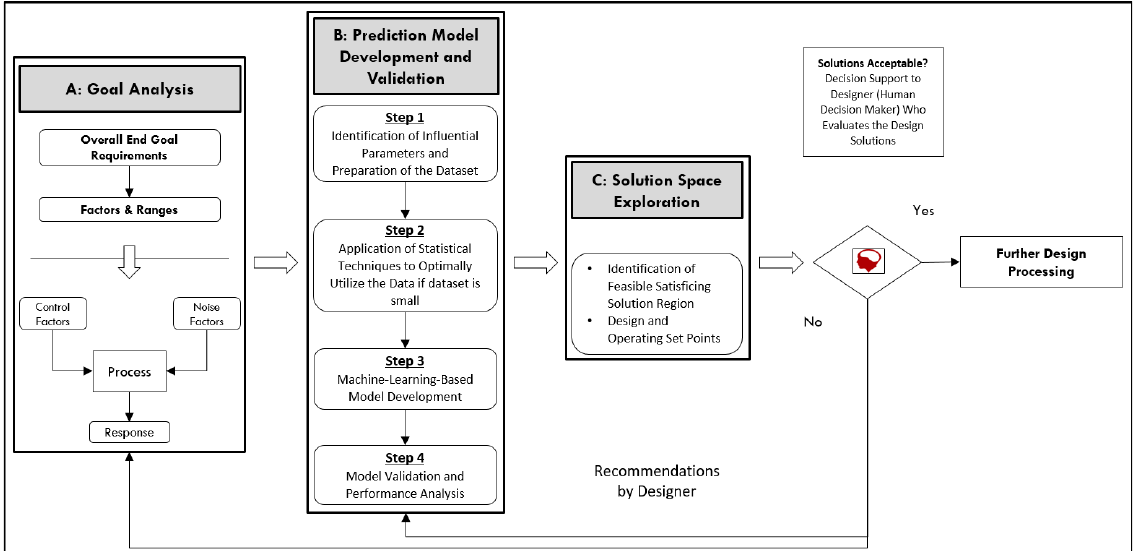
Figure 2. Design Space Exploration Framework.